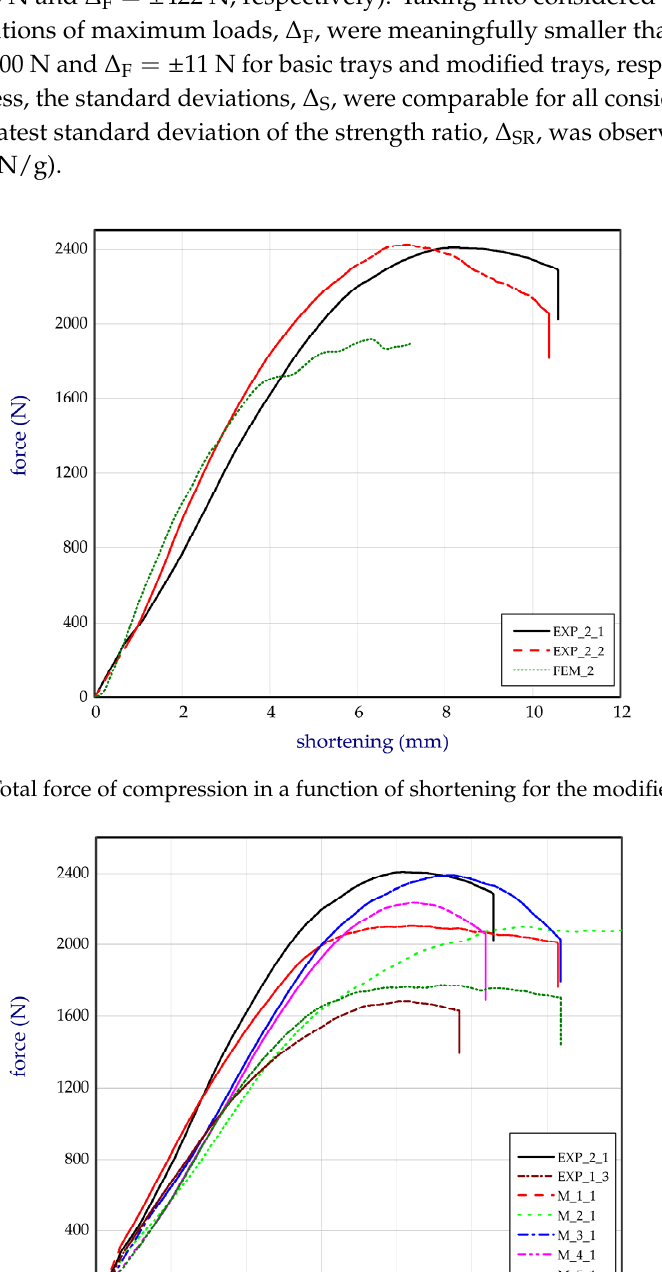
Figure 13. Comparison of curves (force versus shortening) based on different models.